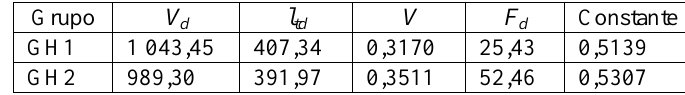
Tabla 2: Valores de los parámetros del modelo por grupo homogéneo.